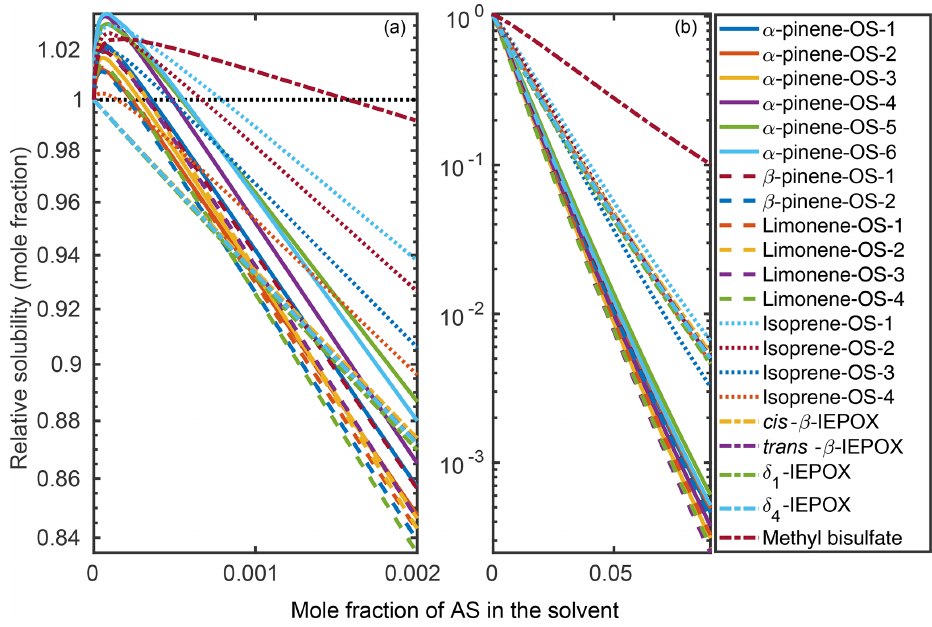
Figure 4. Relative solubilities of OS in ( NH 4 ) 2 SO 4 (aq) solutions ( T = 298 . 15K relative to pure water) estimated in COSMO therm using relative screening. (a) Results for the lower binary salt mole fraction range from 0 to 2 × 10 − 3 and (b) the whole range between 0 and 0.09 mole fraction of the salt. The black dotted line in (a) shows the relative solubility of 1, equivalent to the solubility of the OS in pure water.